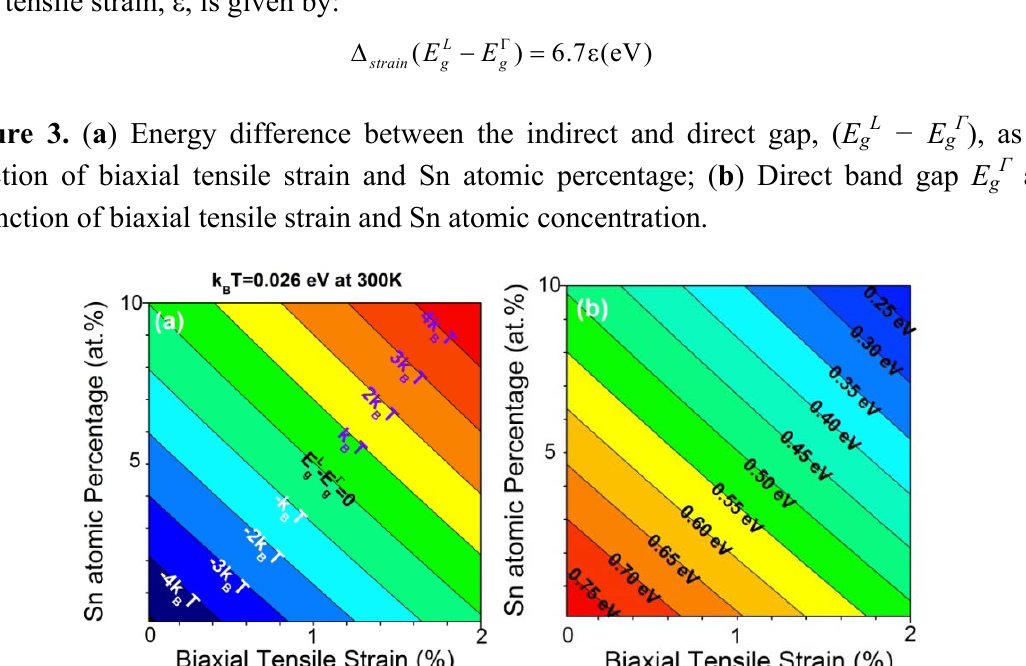
Γ ), as a g Γ as g